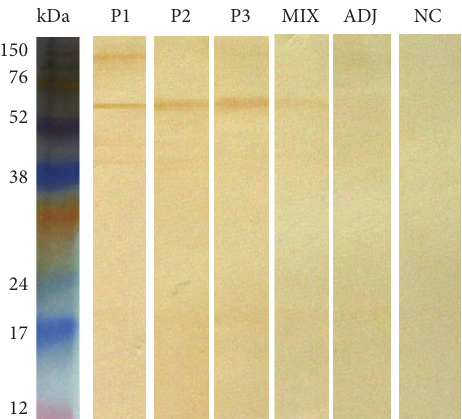
Figure 2: Anti-peptide antibody reactivity to L. braziliensis antigens by western blot. Forty micrograms of L. braziliensis antigen was separated by 15% SDS-PAGE and then, using western blot, was reacted with anti-peptide serum P1 (lane 1), anti-peptide serum P2 (lane 2), anti-peptide serum P3, anti-peptide serum MIX, sera against Freund’s adjuvant (lane 5), and NC = negative control → nonimmuneserum (lane6). Sera from theimmunized hamster were tested at a 1: 100 dilution. The detection reaction was performed with anti-hamster IgG (whole molecule) antibody conjugated to peroxidase (100 𝜇 g/mL).